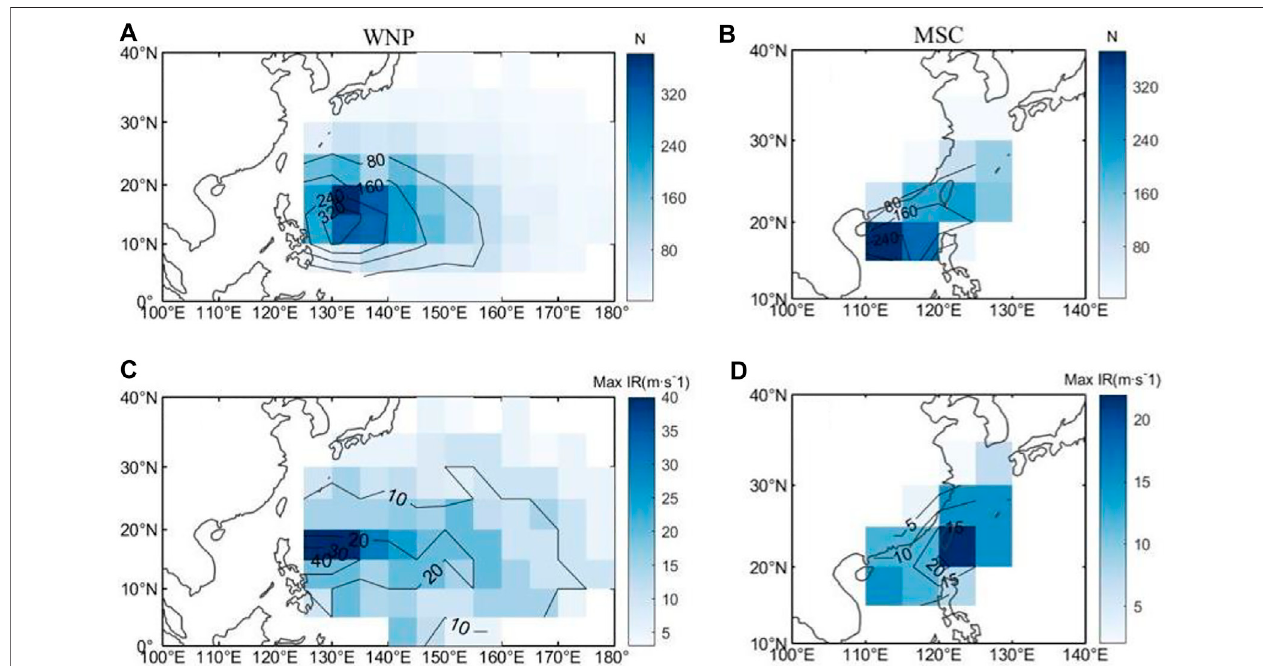
FIGURE4| Spatialdistributionsoffrequencyof (A,B) allintensi fi cationcasesand (C,D) maximumintensi fi cationrate(MaxIR;m s − 1 )ineach5 ° × 5 ° gridboxoverthe WNP (A,C) and the MSC (B,D) . IR, TC in intensi fi cation rate.